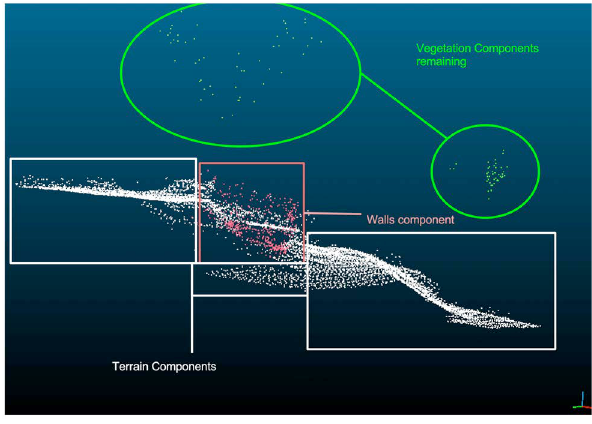
Figure 7. Post roughness segmentation points remain which represent terrain areas (white), standing remains (pink) and vegetation (green). The separations shown here are made on the basis of the local point density distribution.